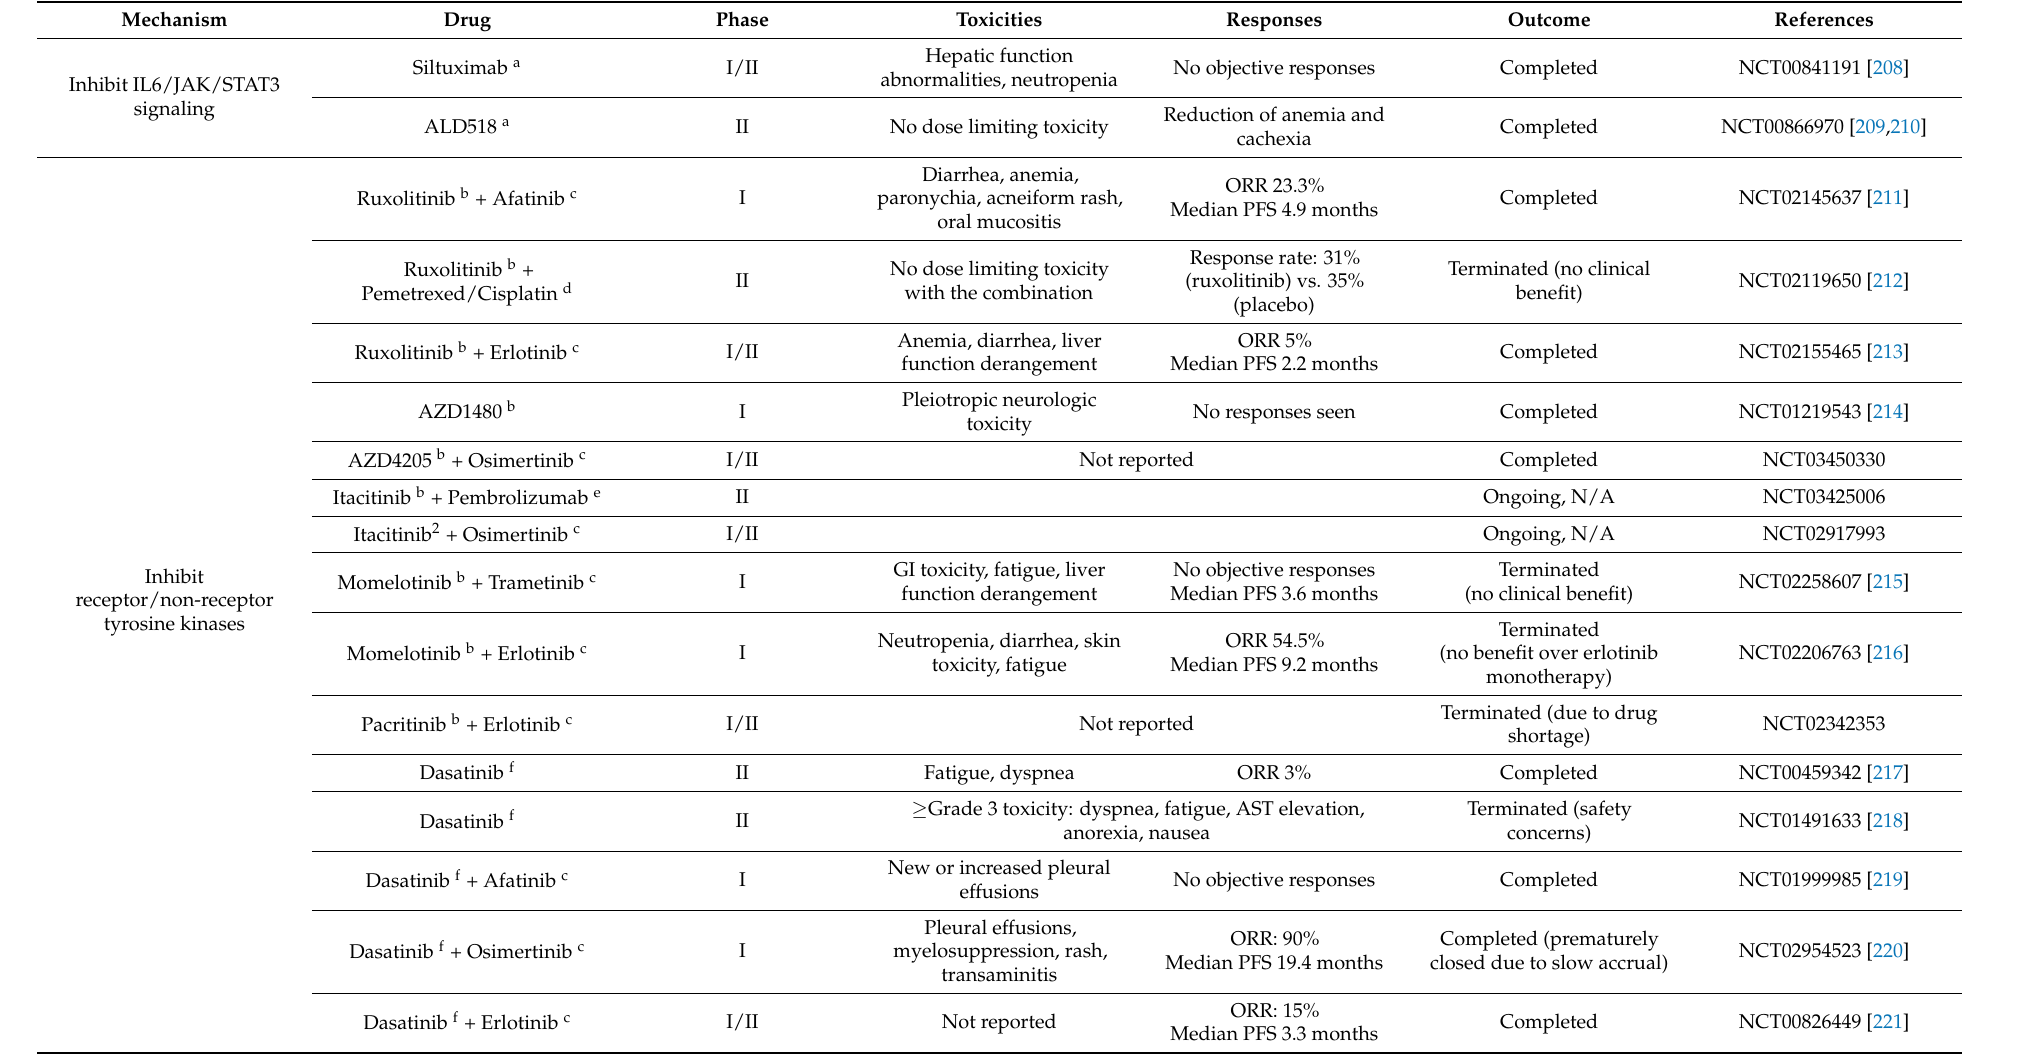
Table 1. Clinical trials assessing STAT3 inhibition in